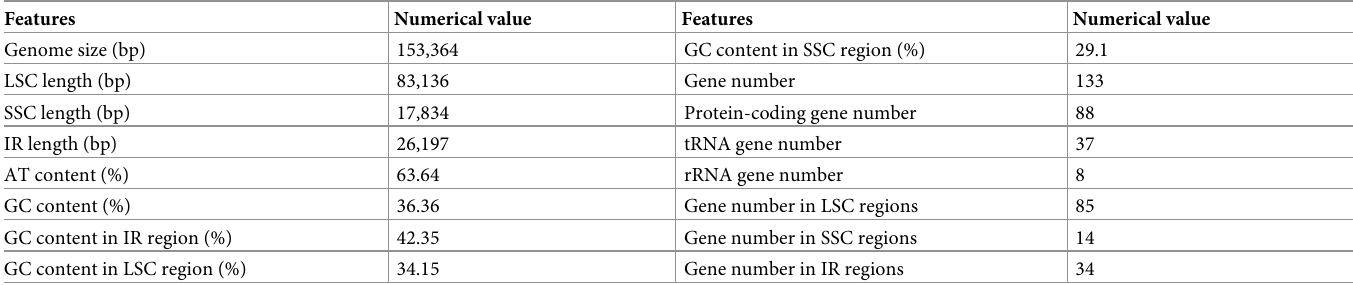
Table 1. Summary of cp genome of B . oleracea var. italica